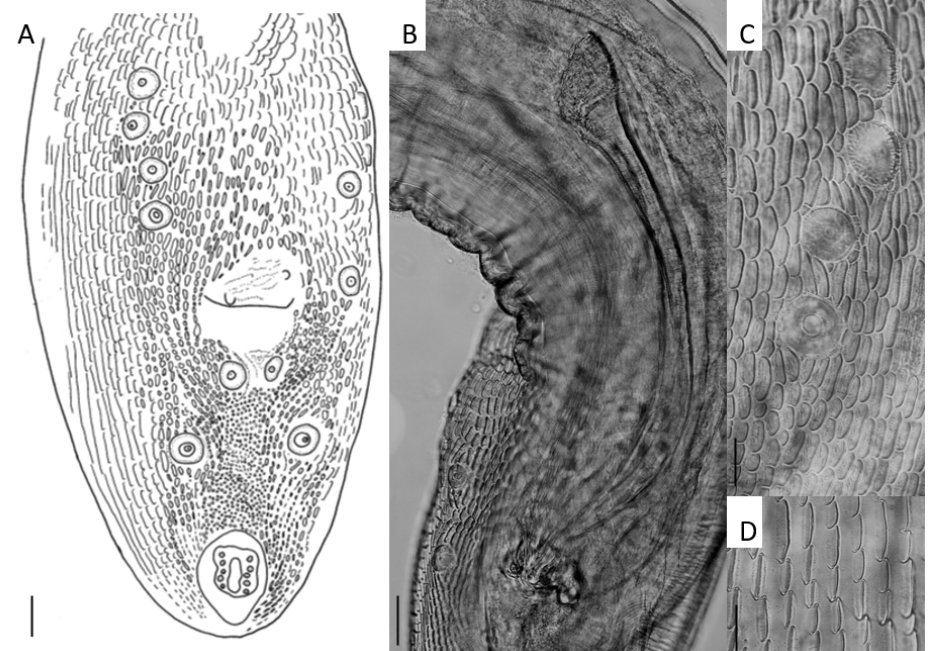
Figure 3. Gendrespirura cf. zschokkei collected from Manis javanica . Male specimen. ( A ) Line drawing of posterior end, showing caudal alae, pre- and post-cloacal papillae, pattern of ventral ridges and cloaca, ventral view. ( B ) Photomicrograph of right spicule in situ, ventral view. ( C ) Photomicrograph of pre-cloacal papillae. ( D ) Photomicrograph of ridges on ventral surface of nematode, anterior to cloacal region. Scale bars: ( A ) 50 µm. ( B ) 50 µm. ( C ) 25 µm. ( D ) 20 µm. Male (based on a single specimen; Figure 3): Posterior extremity spirally coiled, cau- dal alae well developed, symmetrical. Four pairs of preanal pedunculate papillae (Figure 3C), 1 pair of preanal sessile papilla, and 2 pairs post-anal papillae (Figure 3A). Pre-anal and post-anal pedunculate papillae approximately equal in size, 32 (28.25-35) µm long by 31 (27.5–37.5) µm wide. Spicules uneven (Figure 3B); left spicule very long and slender with terminal hook (ratio of length of spicule to total length 0.254); right spicule short and stout (ratio of length of spicule to total length 0.054); ratio of length of left spicule to right spicule 4.69. Gubernaculum present. Cluster of 5 pairs of small papillae present at poste- rior extremity (Figure 3A). Posterior papillae 7.5 µm long. Cloacal region, and ventral sur- face of body immediately anterior, covered with small cuticular elongate ridges or bosses (Figure 3D); post-cloacal median region covered with small cuticular rounded bosses. Molecular characterization: Only Cox1 sequences were successfully obtained from seven specimens of G. cf. zschokkei . The length of the Cox1 sequences is 649 bp. The intra- specific variation ranged from 0–0.22% among the sequences. There are no other se- quences for species of Gendrespirura available in GenBank. Gendrespirura cf. zschokkei se- quences formed a highly supported and distinct group in the phylogenetic tree (Figure 4A) and were closely related to Tetrameres grusi (Shumakovich, 1946), collected from red- necked cranes in China [29] within a clade of species of Habronema Diesing, 1861.